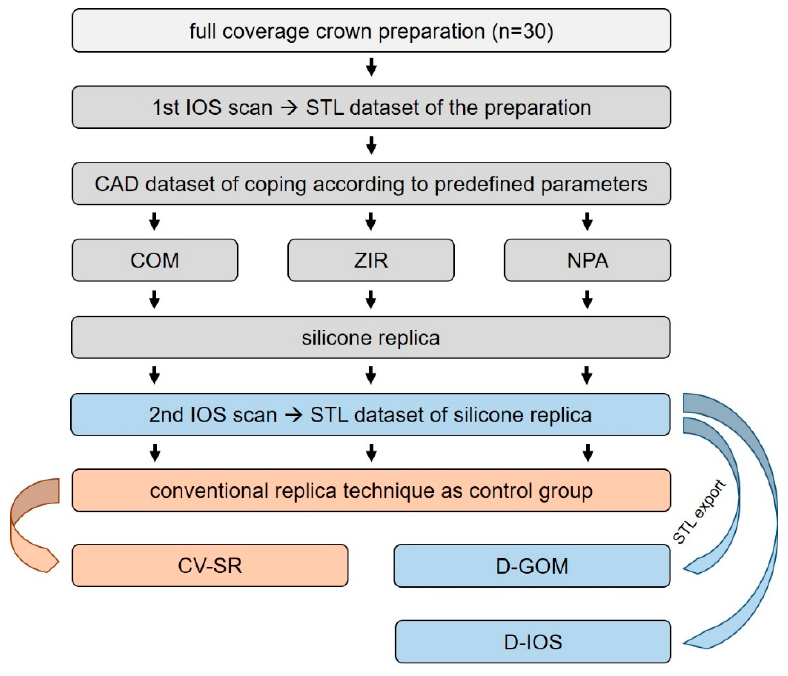
Figure 1. Flow scheme of the clinical trial.